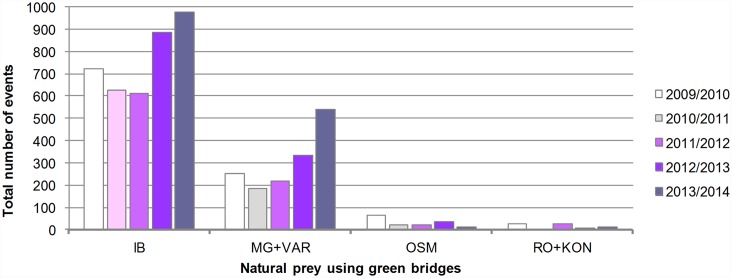
Abundance trends of natural prey (roe deer, red deer and wild boar combined) on the monitored green bridges.Event—a photograph/movie of natural prey.